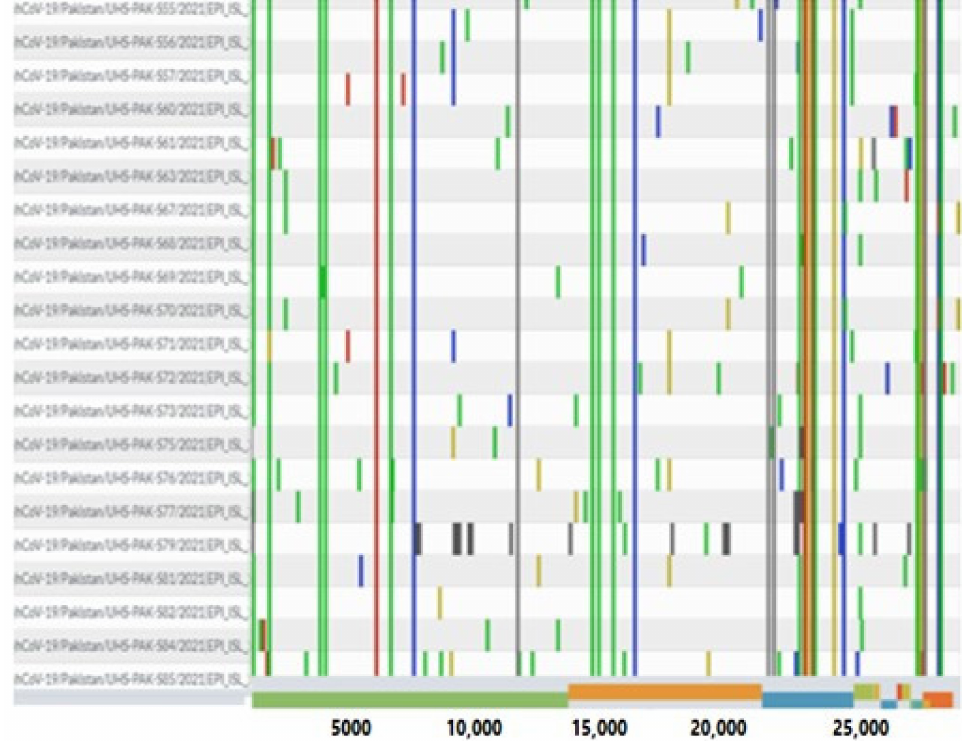
Figure 6. Genomic map of SARS-CoV-2 genomes of Pakistan. The reference genome in this coverage map is